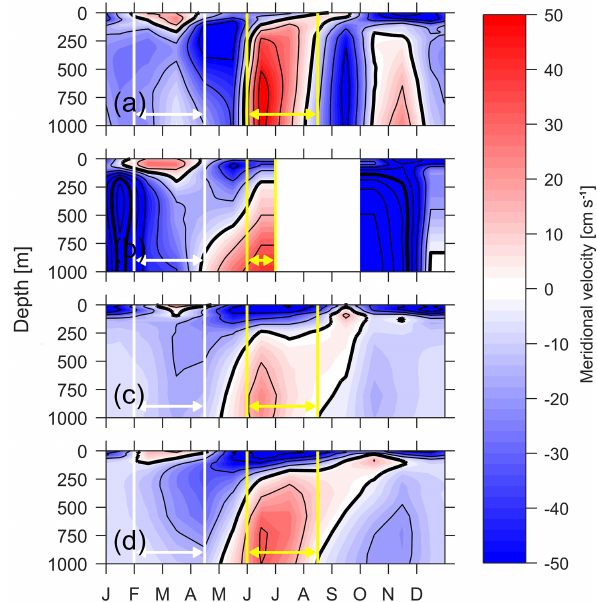
Figure 3. Bimonthly-mean seasonal variation of the meridional geostrophic velocity referenced to the surface satellite ADT across the magenta transect in Fig. 1 from hydrography and Argo mea- surements (a) , glider measurements (b) , monthly-mean meridional velocity profiles from HYCOM (c) , and POP (d) output. Line con- tours are plotted in the same manner as in Fig. 2. White and yellow lines indicate periods when the undercurrent is most